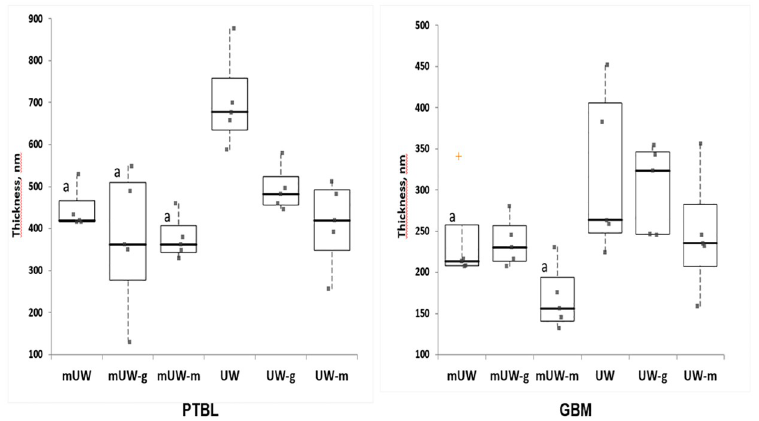
Fig 7. The PTBL and GBM thickness measurement from 72 th hour of the kidney samples within preservation solutions. a: Significantly different from UW group (p <